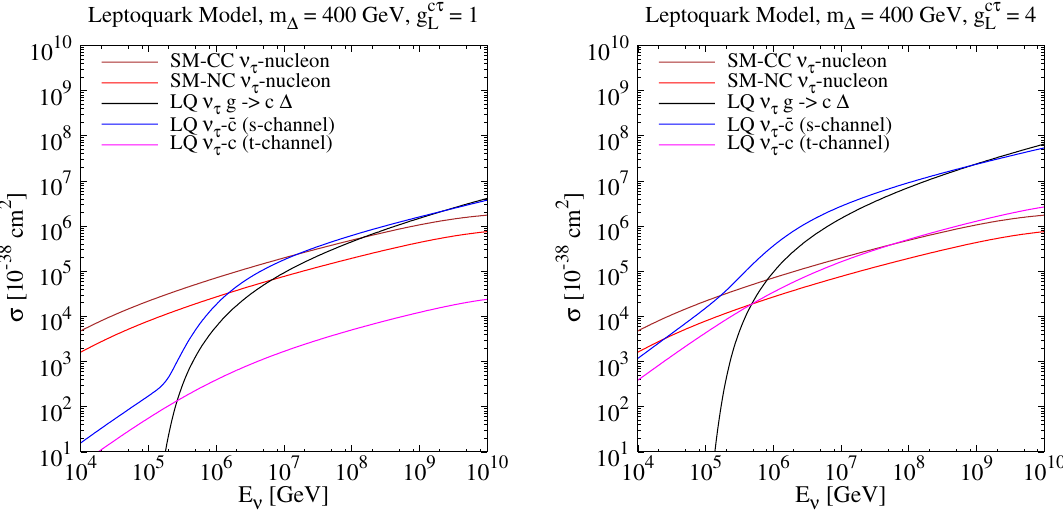
Figure 9 . (cid:23) (cid:28) -nucleon cross sections: CC contribution in the SM, NC contribution in the SM, (cid:23) (cid:28) -gluon contribution, (cid:23) (cid:28) -c-quark s-channel contribution, (cid:23) (cid:28) -c-quark t-channel contribution. For the LQ cross sections m (cid:1) = 400 GeV and g c(cid:28)